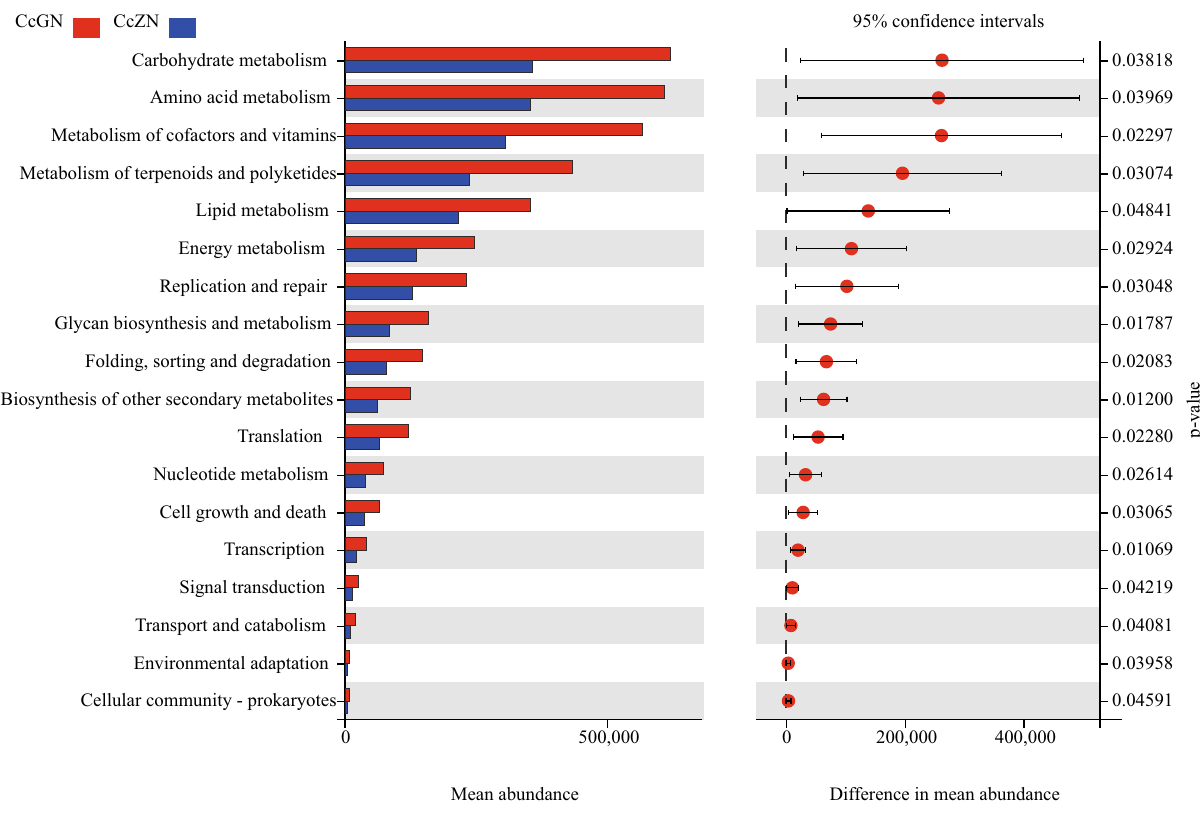
Figure 3. Prediction and analysis of significant differences between bacterial community distributions in the endospheres of healthy and diseased Cc . The pathways were predicted based on 16S sequences. The predicted metabolic pathways belonging to ‘Organismal Systems’ and ‘Human Diseases’ in the KEGG database were discarded.